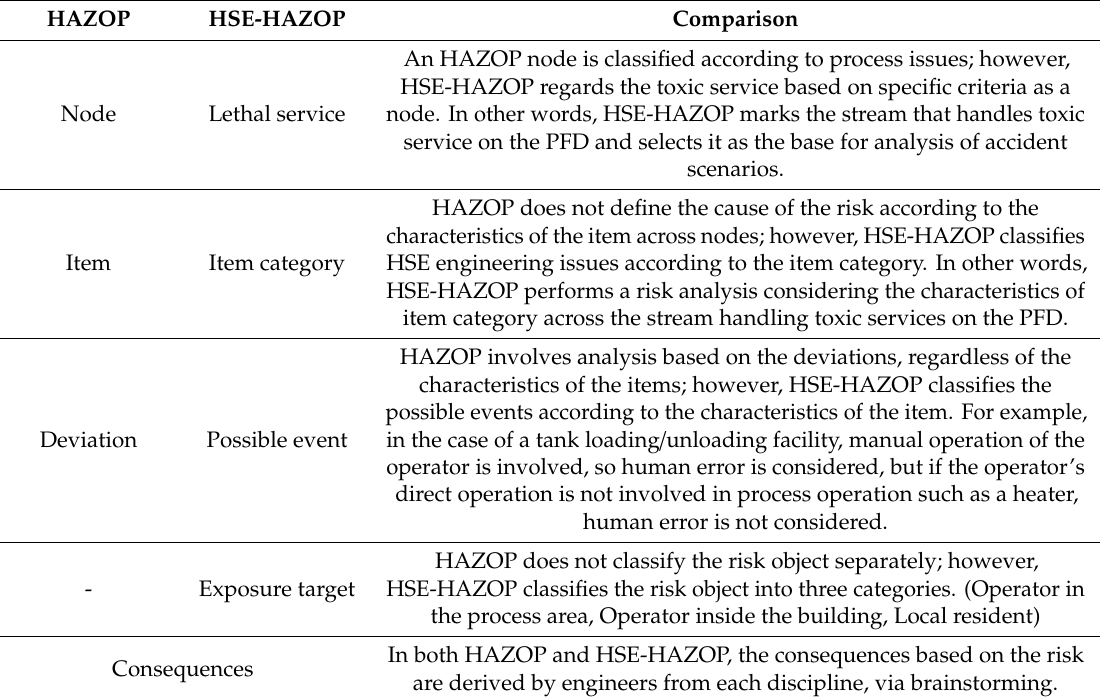
Table 9. Comparison between HAZOP and